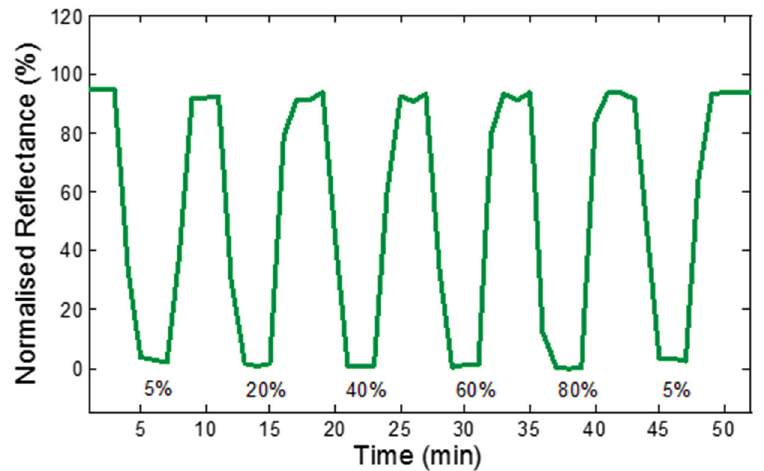
Figure 7. Dynamic response of uncoated sensor, towards different concentrations of ethanol, integrated over wavelength range of 500–800 nm.